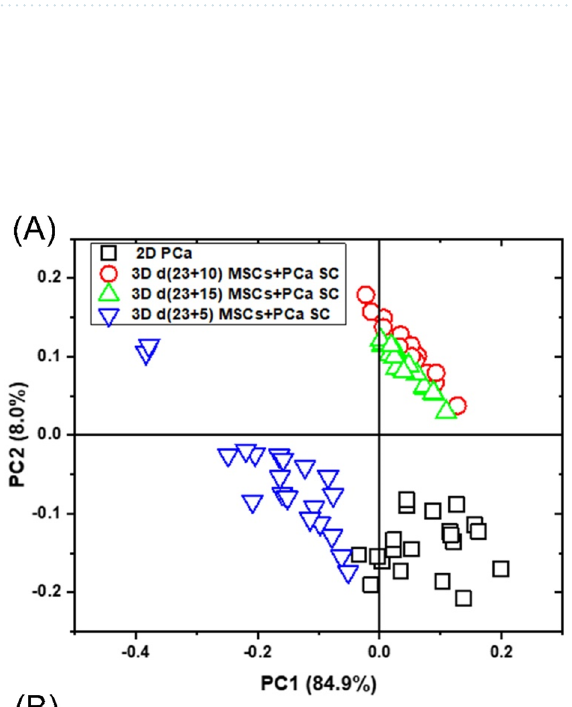
Table 1. Band assignments for Raman spectra for prostate cancer cells 14,30–35 .